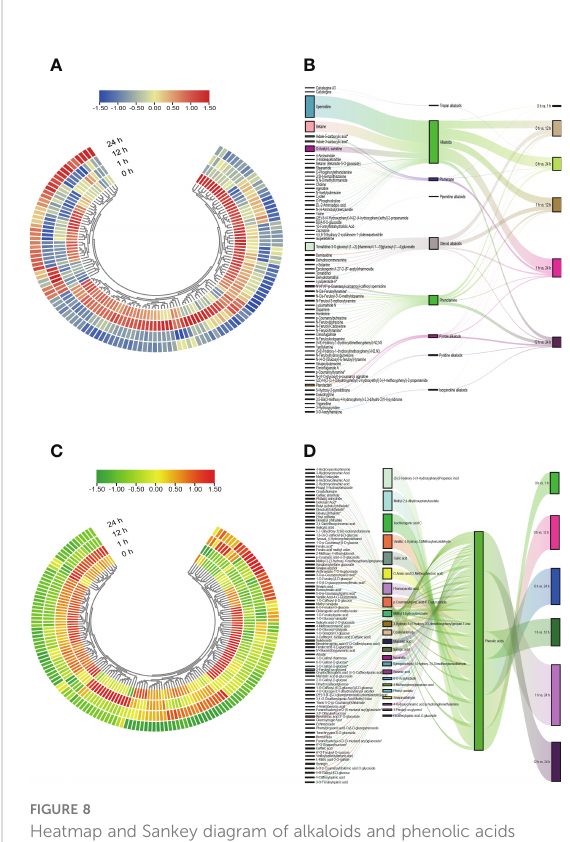
FIGURE 8 Heatmap and Sankey diagram of alkaloids and phenolic acids class of substances. (A) Heatmap of the changes of alkaloids in S. lycopersicum roots under different salt stress treatment periods. (B) Sankey diagram of mobility of alkaloids in S. lycopersicum roots in comparison groups with different salt stress treatments. (C) Heatmap of the changes of phenolic acids in S. lycopersicum roots under different salt stress treatment periods. (D) Sankey diagram of the mobility of phenolic acids in S. lycopersicum roots in comparison groups with different salt stress treatments. Heatmap is used to map each value in the data matrix to a color display according to a certain pattern, and the color change is used to visualize the data. Sankey diagrams were used to describe the fl ow from one set of values to another, with squares representing metabolites, classi fi cation, comparison groups, etc., and bars representing the mobility between them, with the width of the bars proportional to the size of the mobility.